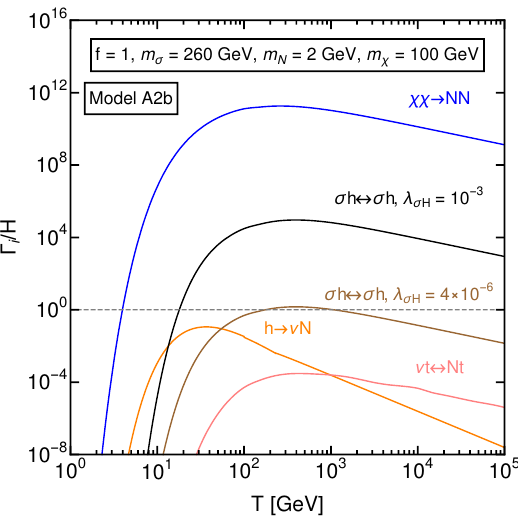
Figure 7 . Rates of the most relevant 1 ↔ 2 and 2 ↔ 2 processes in Model A2b normalised to the Hubble rate. The parameters have been fixed to f = 1 , m m σ = 260 GeV. They correspond to a point in figure 4 yielding the correct value of relic abundance and avoiding all the experimental